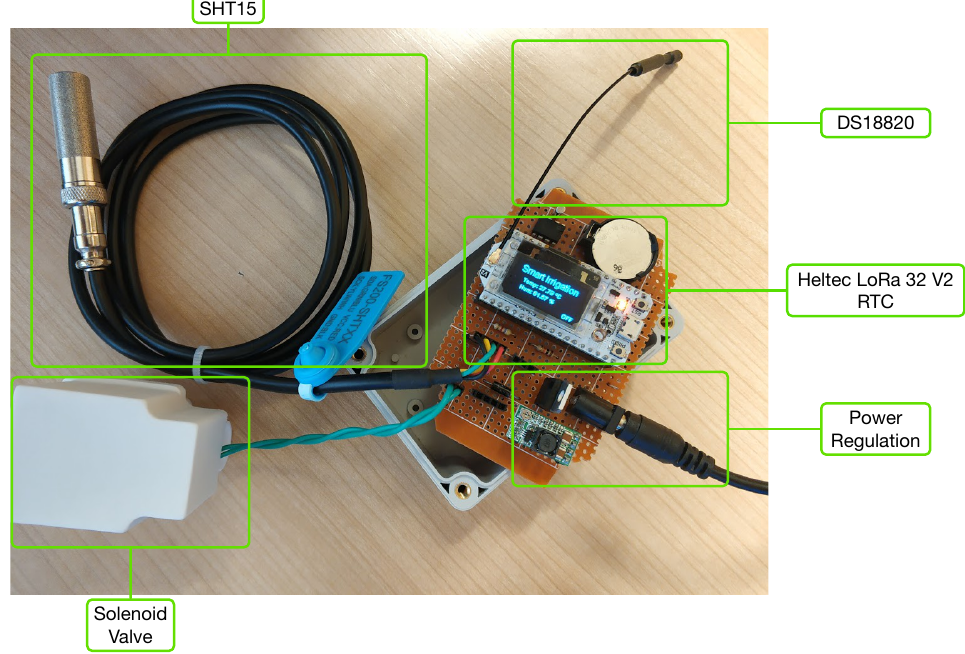
Figure 5. Disassembled smart irrigation node and its internal